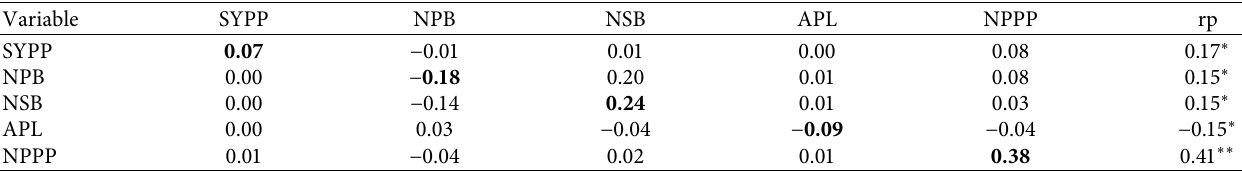
Table 6: Estimates of direct (bold-diagonal) and indirect efects (of-diagonal) path at phenotypic levels of the 10 traits on seed yield per plant in 160 fenugreek accessions.